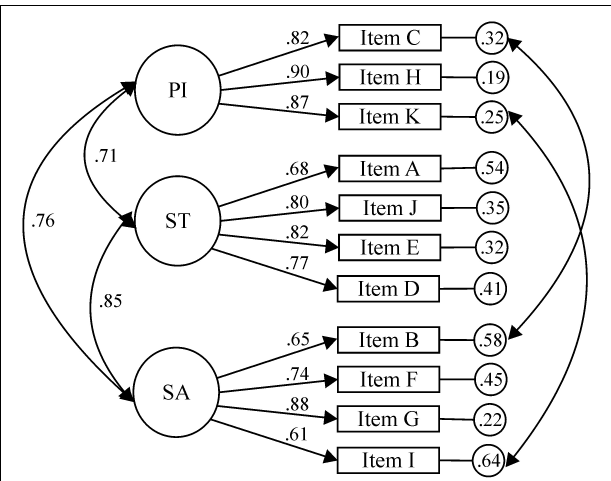
FIGURE 1 | Intellectual disability sub-scale.